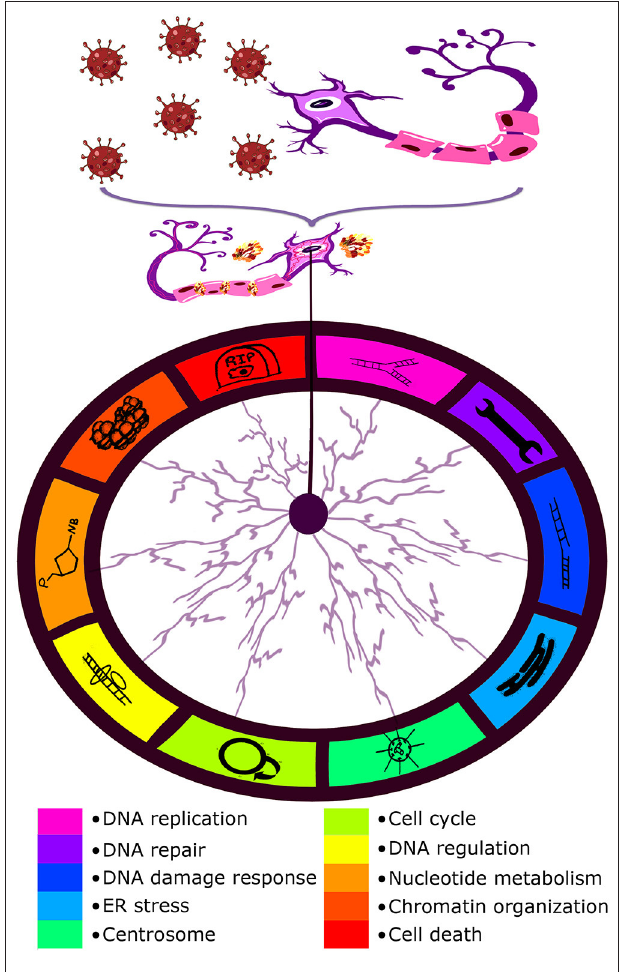
FIGURE 1 | Schematic representation of the possible effect of SARS-CoV-2 infection (COVID-19) on the brain in the context of aging-related genome (chromosome) instability. Interactome analysis of SARS-CoV-2 infection has highlighted a number of pathways to be potentially altered by the virus which are listed at the bottom of the